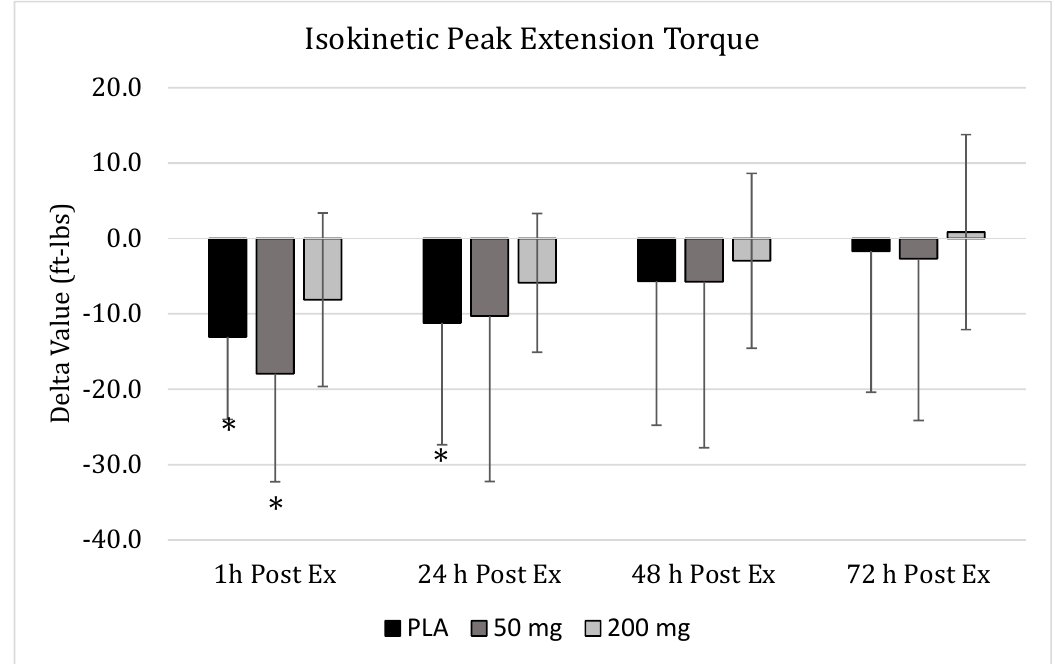
Figure 3. Isokinetic Peak Extension Torque. Changes in isokinetic peak extension torque as measured via an isokinetic dynamometer 1 h, 24 h, 48 h, and 72 h post-muscle damaging exercise, downhill run, in placebo ( ), 50 mg of CUR (in the form of 250 mg of CurcuWIN ® ) ( ), and 200 mg of CUR (in the form of 1000 mg of CurcuWIN ® ) ( ). * = Significantly di ff erent than respective baseline